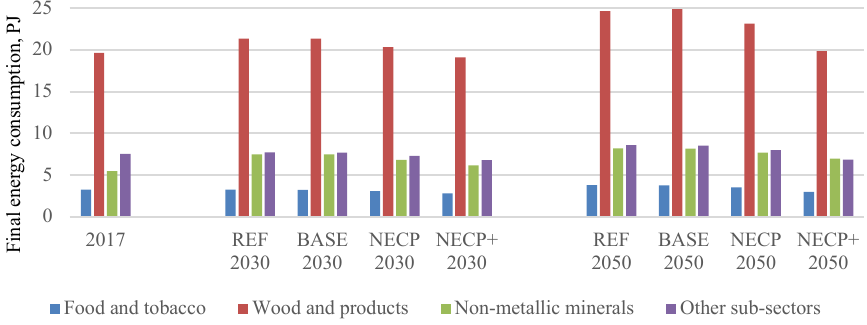
Fig. 7. Final energy consumption in industry sub-sector in the modelled scenarios.